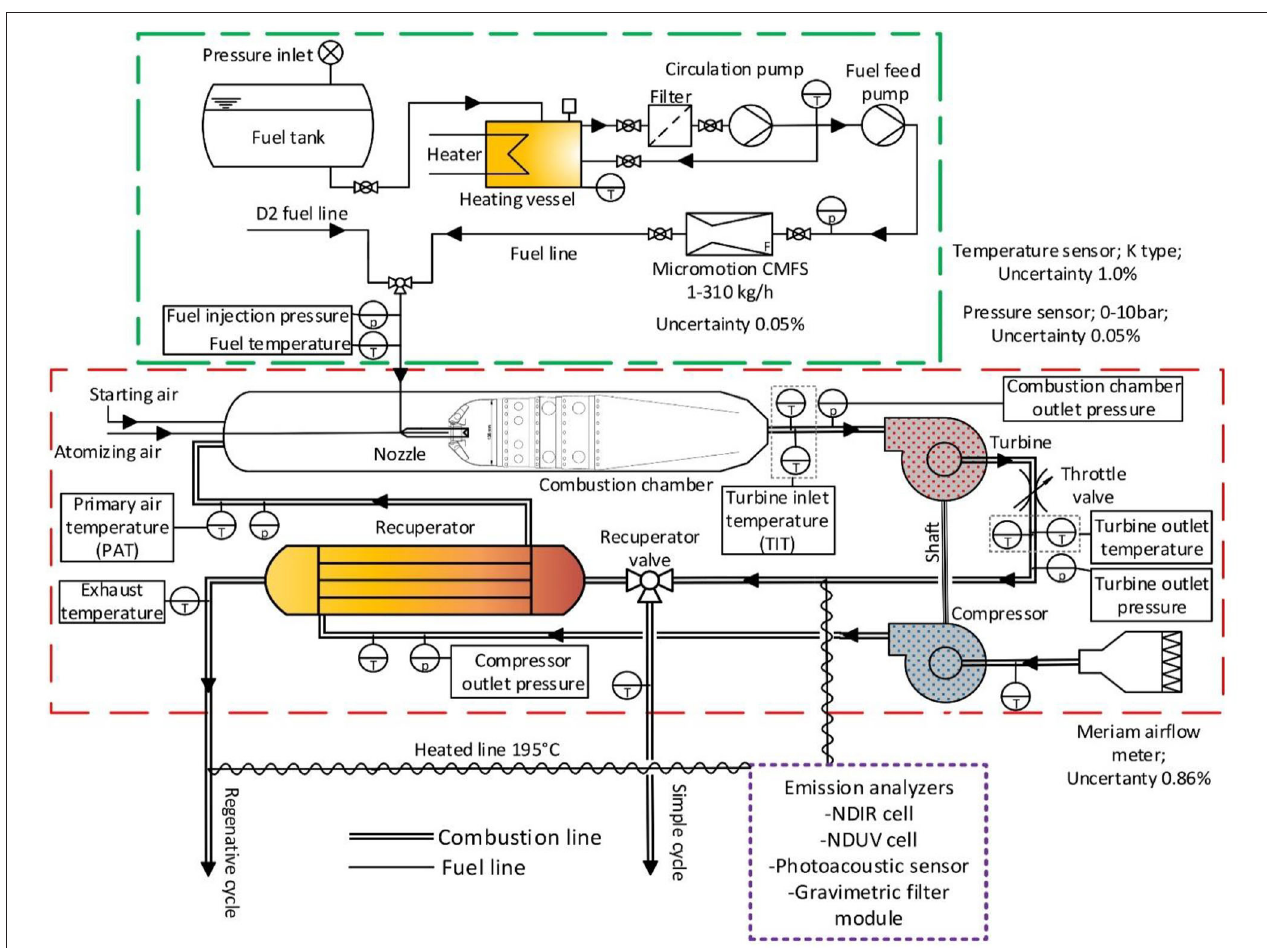
FIGURE 4 | Scheme of the experimental rig used for evaluating combustion performance of evaluated